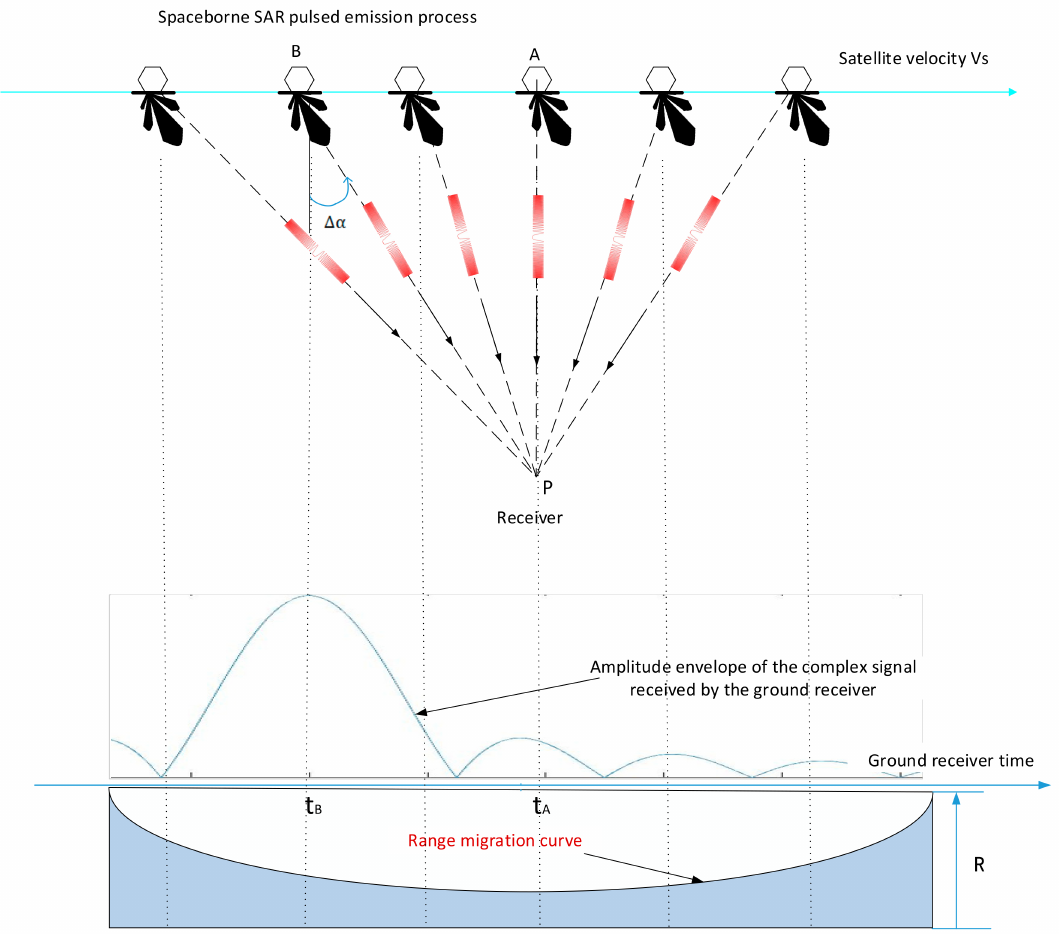
Figure 4. The situation where the squint angle of the antenna beam is not 0. R denotes the distance between the satellite and the ground